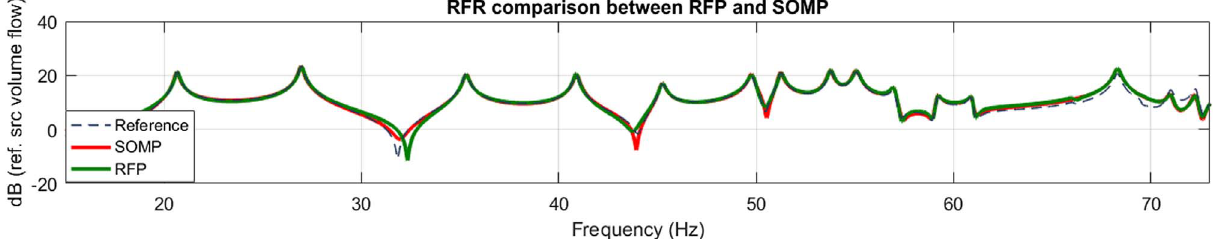
Figure 4. Reconstruction of the RFR at a point inside the room using SOMP and RFP in comparison with the FEM ground truth reference.